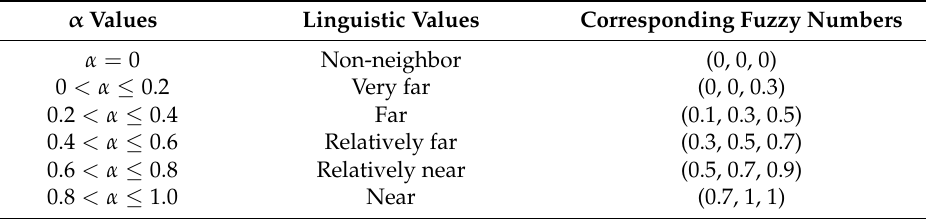
Table 1. Linguistic values and their corresponding fuzzy numbers for neighborhood types. α Values Linguistic Values Corresponding Fuzzy Numbers α = 0 Non-neighbor (0, 0, 0) 0 < α ≤ 0.2 Very far (0, 0, 0.3) 0.2 < α ≤ 0.4 Far (0.1, 0.3, 0.5) 0.4 < α ≤ 0.6 Relatively far (0.3, 0.5, 0.7) 0.6 < α ≤ 0.8 Relatively near (0.5, 0.7, 0.9) 0.8 < α ≤ 1.0 Near (0.7, 1, 1)